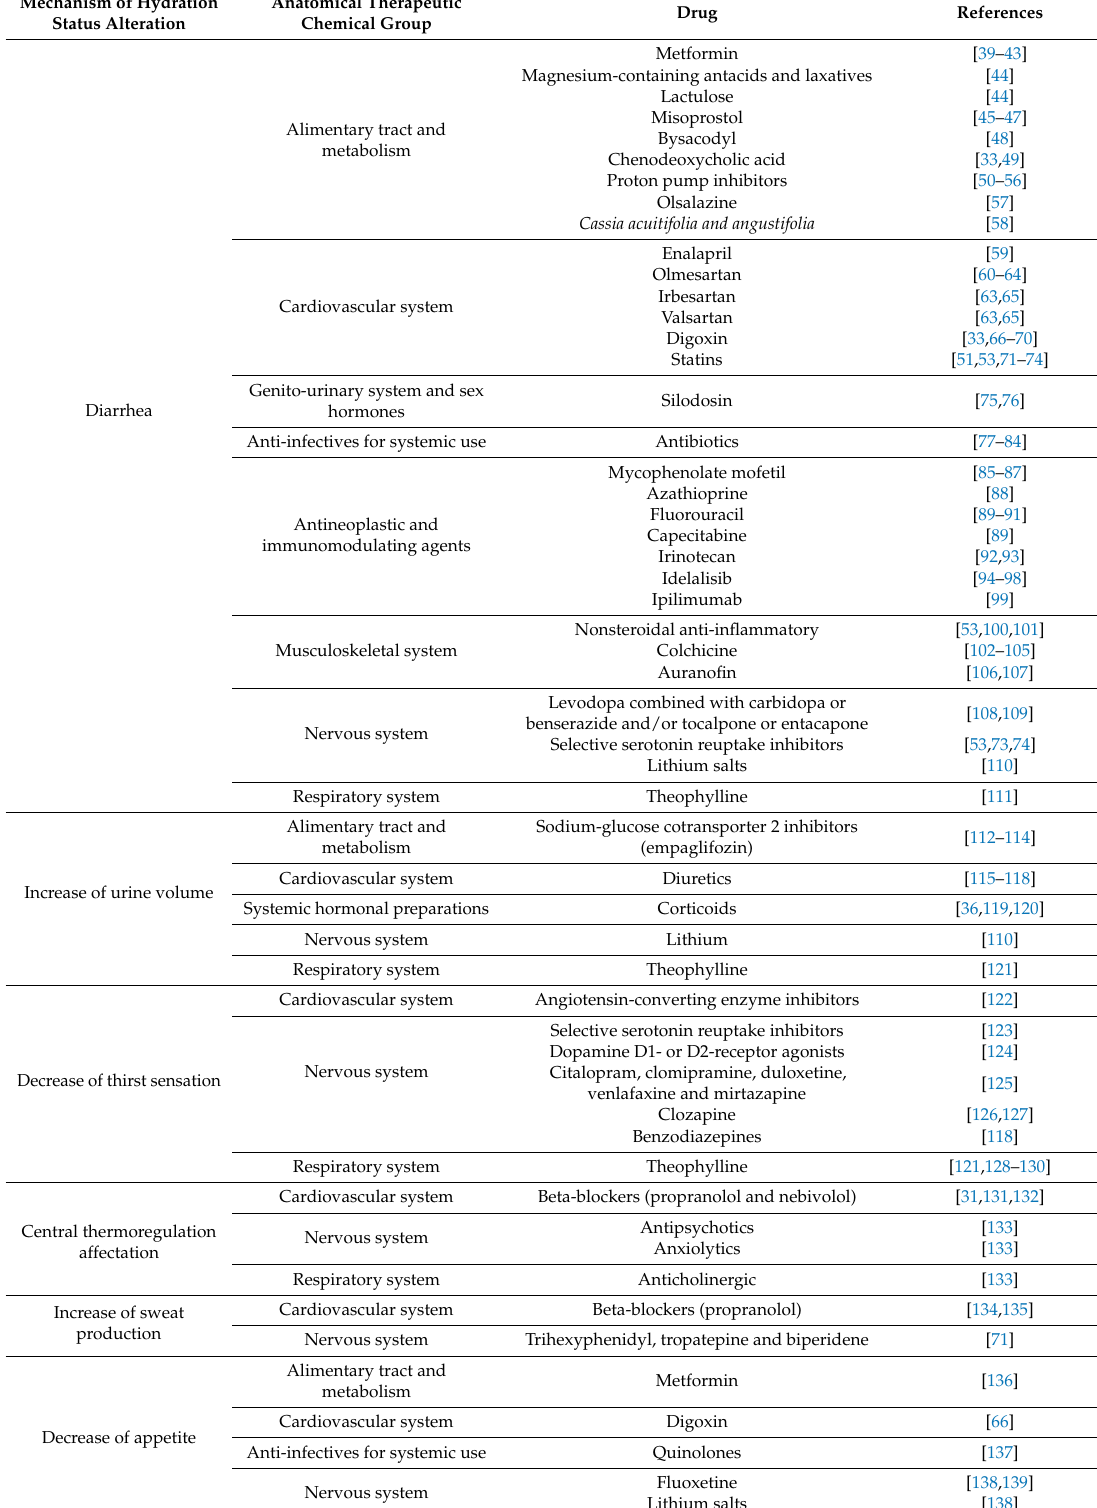
Table 1. Summary of mechanisms and drugs that induce alterations in the hydration